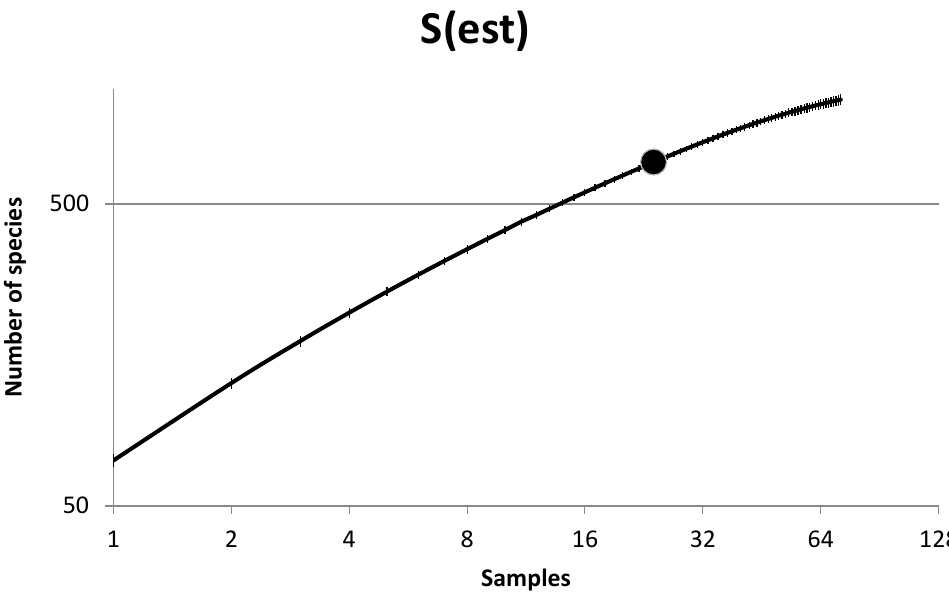
Figure 4. Rarefaction curves of oak diversity extrapolated beyond the dot (i.e., 24 trees) to yield 72 treatments (i.e., trees). The dot shows the number of species sampled by the number of trees treated. Note the log2 x -axis and the log10 y -axis.